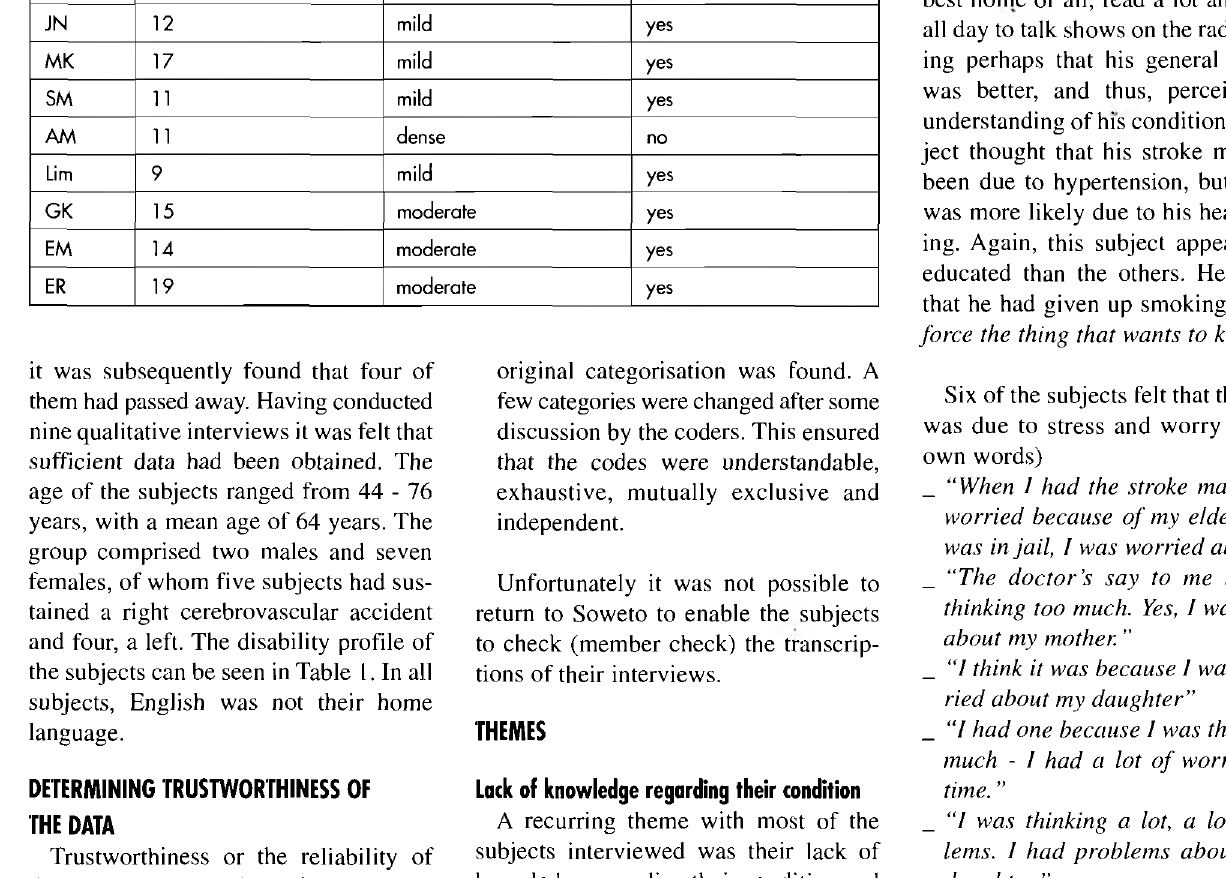
TABLE 1: DISABILITY PROFILE OF THE SUBJECTS Barthel Index